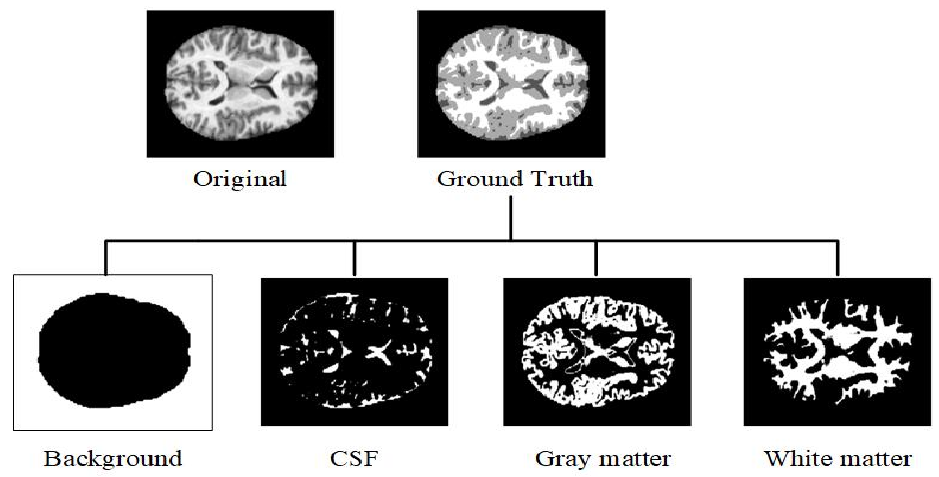
Figure 1. Binary maps generated from the ground truth for different classes.